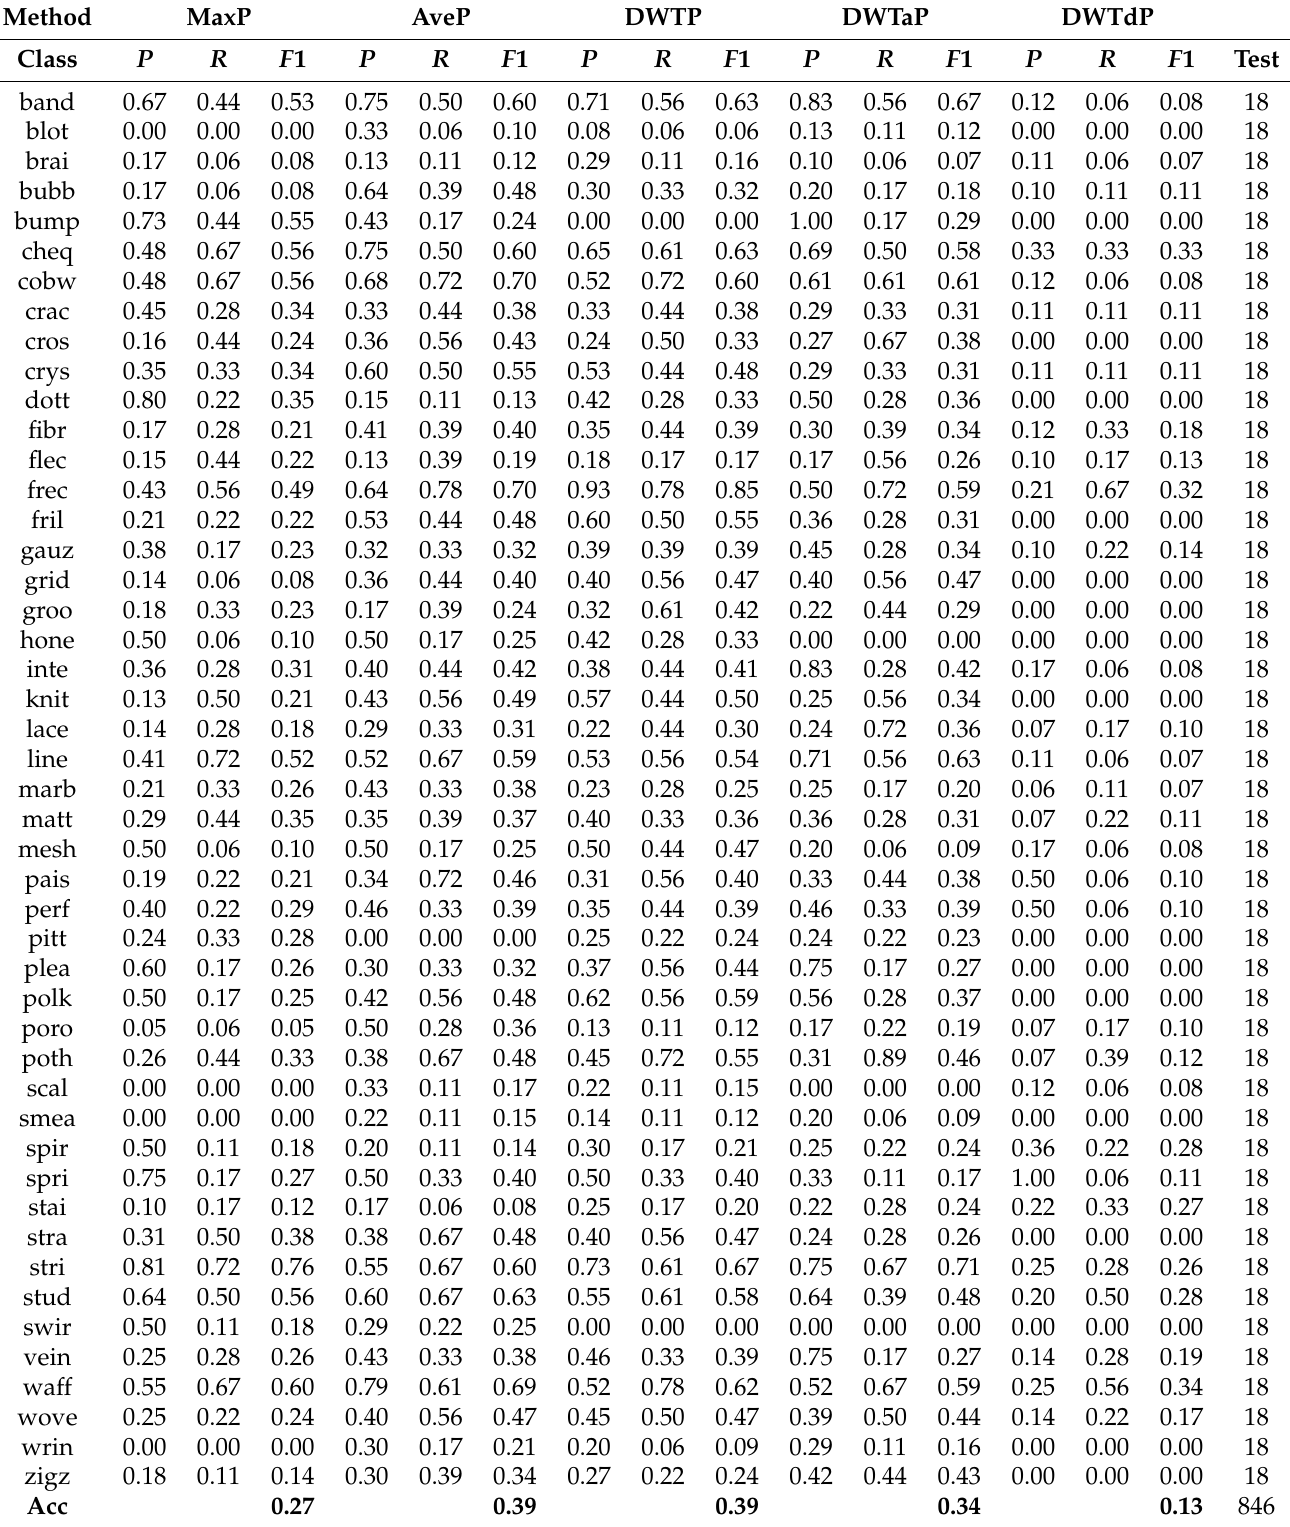
Table A2. Experiment 1 with SGD Optimizer—classification report for the DTD